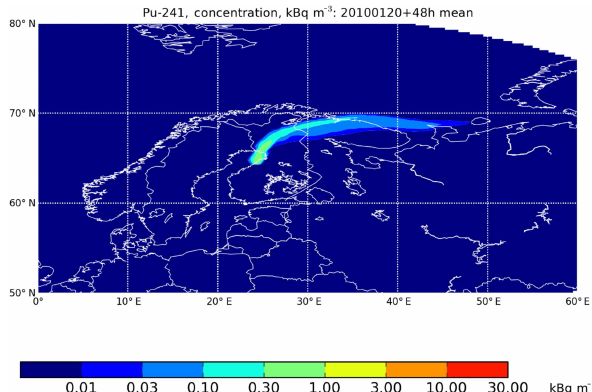
Figure 7. The average activity concentration of 241 Pu in the sur- face air during the first 48h after a hypothetical reactor accident at Pyhäjoki, with an assumed release of 20 January 2010.